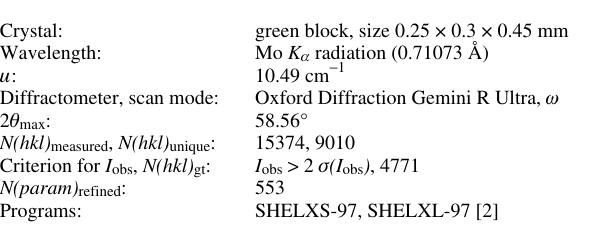
Table 1. Data collection and